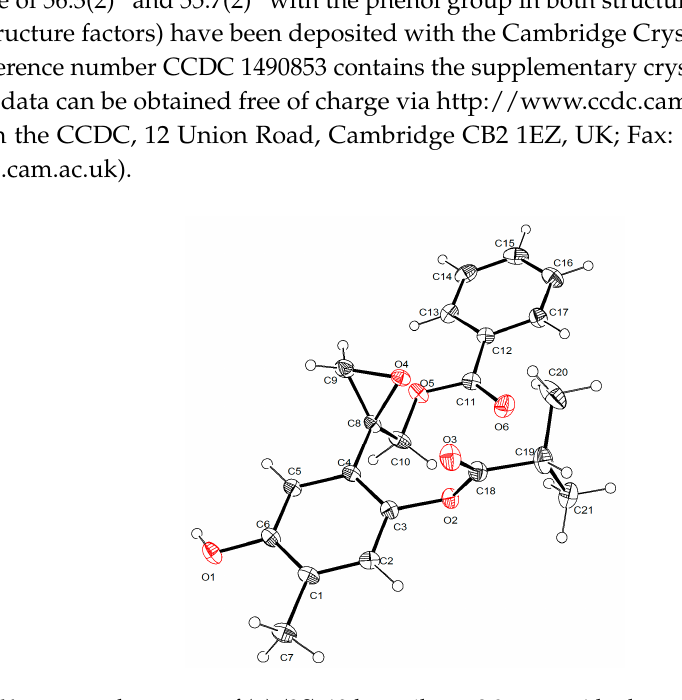
Figure 2. X-ray crystal structure of (+)-(8 S )-10-benzoil-oxy-8,9-epoxy-6-hydroxy thymol isobutyrate ( 1 ).